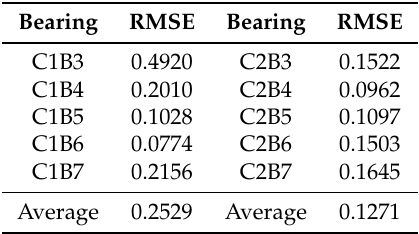
Figure 15. RMS value and predicted RMS value by NSP and CNN-HS in ( a ) C1B6 and ( b ) C2B3 Table 6. The prediction errors using CNN-HS combined with